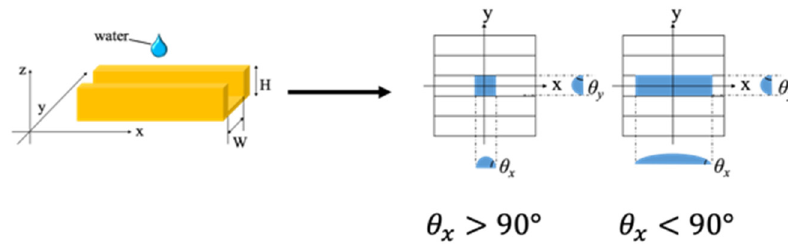
Figure 1. Contact angle measurements for the line-patterned replica mold.